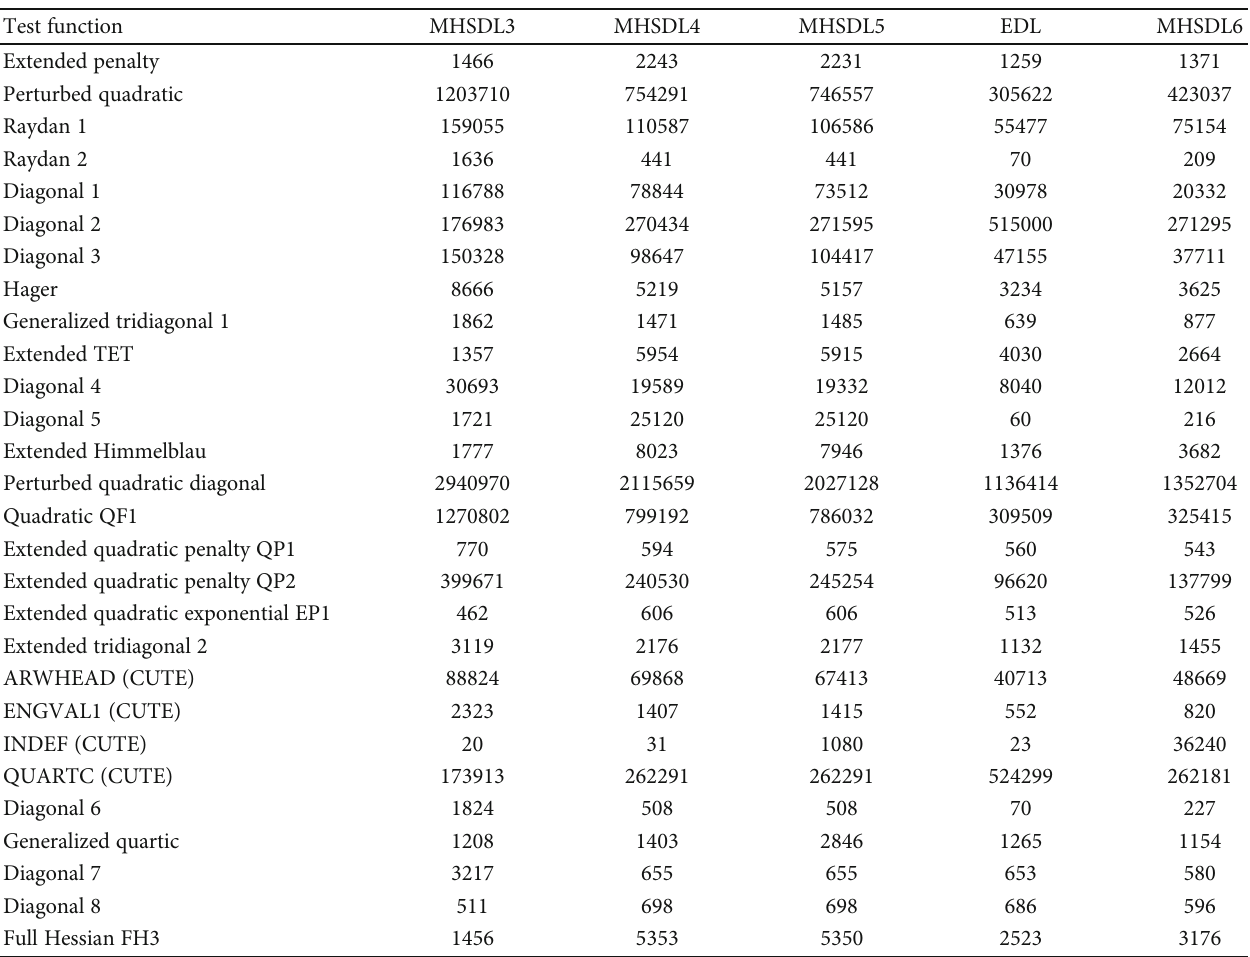
Table 1: Summary results of EDL, MHSDL3, MHSDL4, MHSDL5, and MHSDL6 methods with respect to